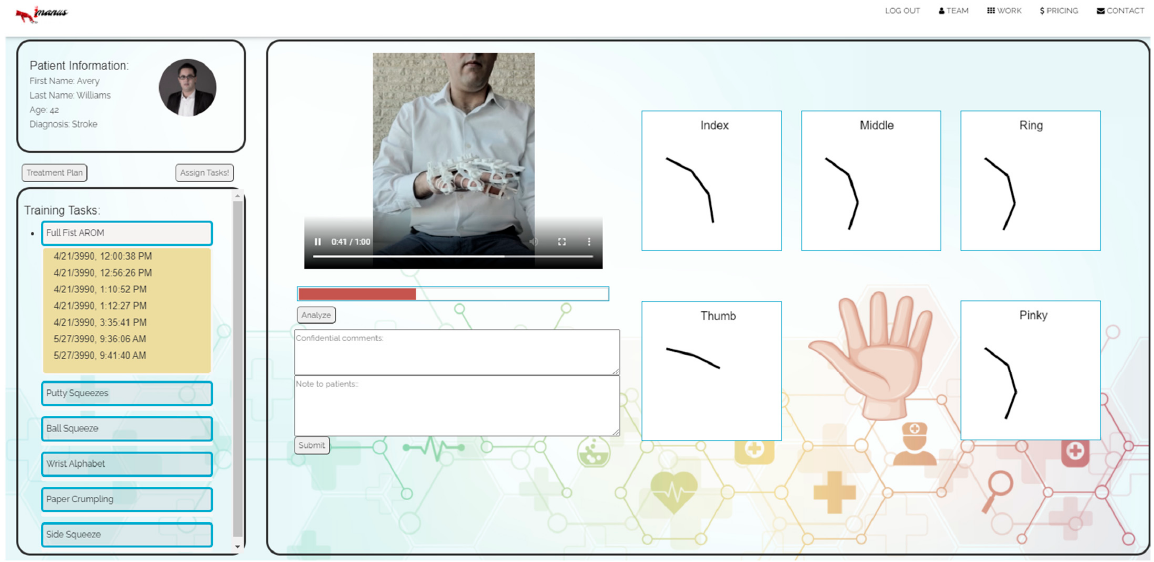
Figure 2. Screenshots of the mobile app at the patient site. A patient has access to exercises prescribed by the therapist and can communicate with the therapist, as well as monitor their performance.